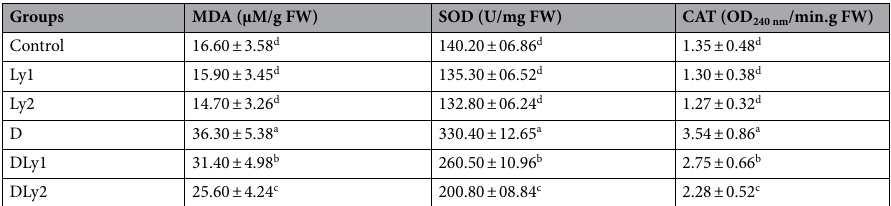
Table 3. Biochemical responses to Dithane and lycopene in root tip cells of A. cepa. Control: tap water, Ly1: 215 mg/L lycopene, Ly2: 430 mg/L lycopene, D: 500 mg/L dithane, DLy1: 500 mg/L dithane + 215